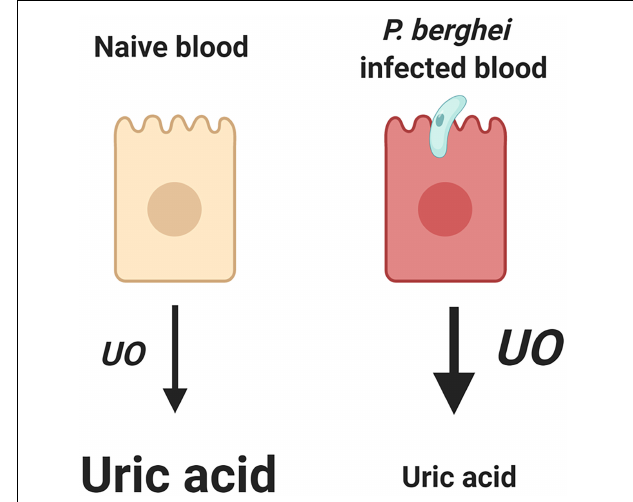
FIGURE 5 | Summary of uric acid metabolism in response to a naïve or P. berghei- infected blood meal. We demonstrate that the mosquito host modulates levels of uric acid through the regulation of urate oxidase ( UO ), where upon infection UO expression is increased, resulting in less uric acid, which consequently limits malaria parasite survival. Created with